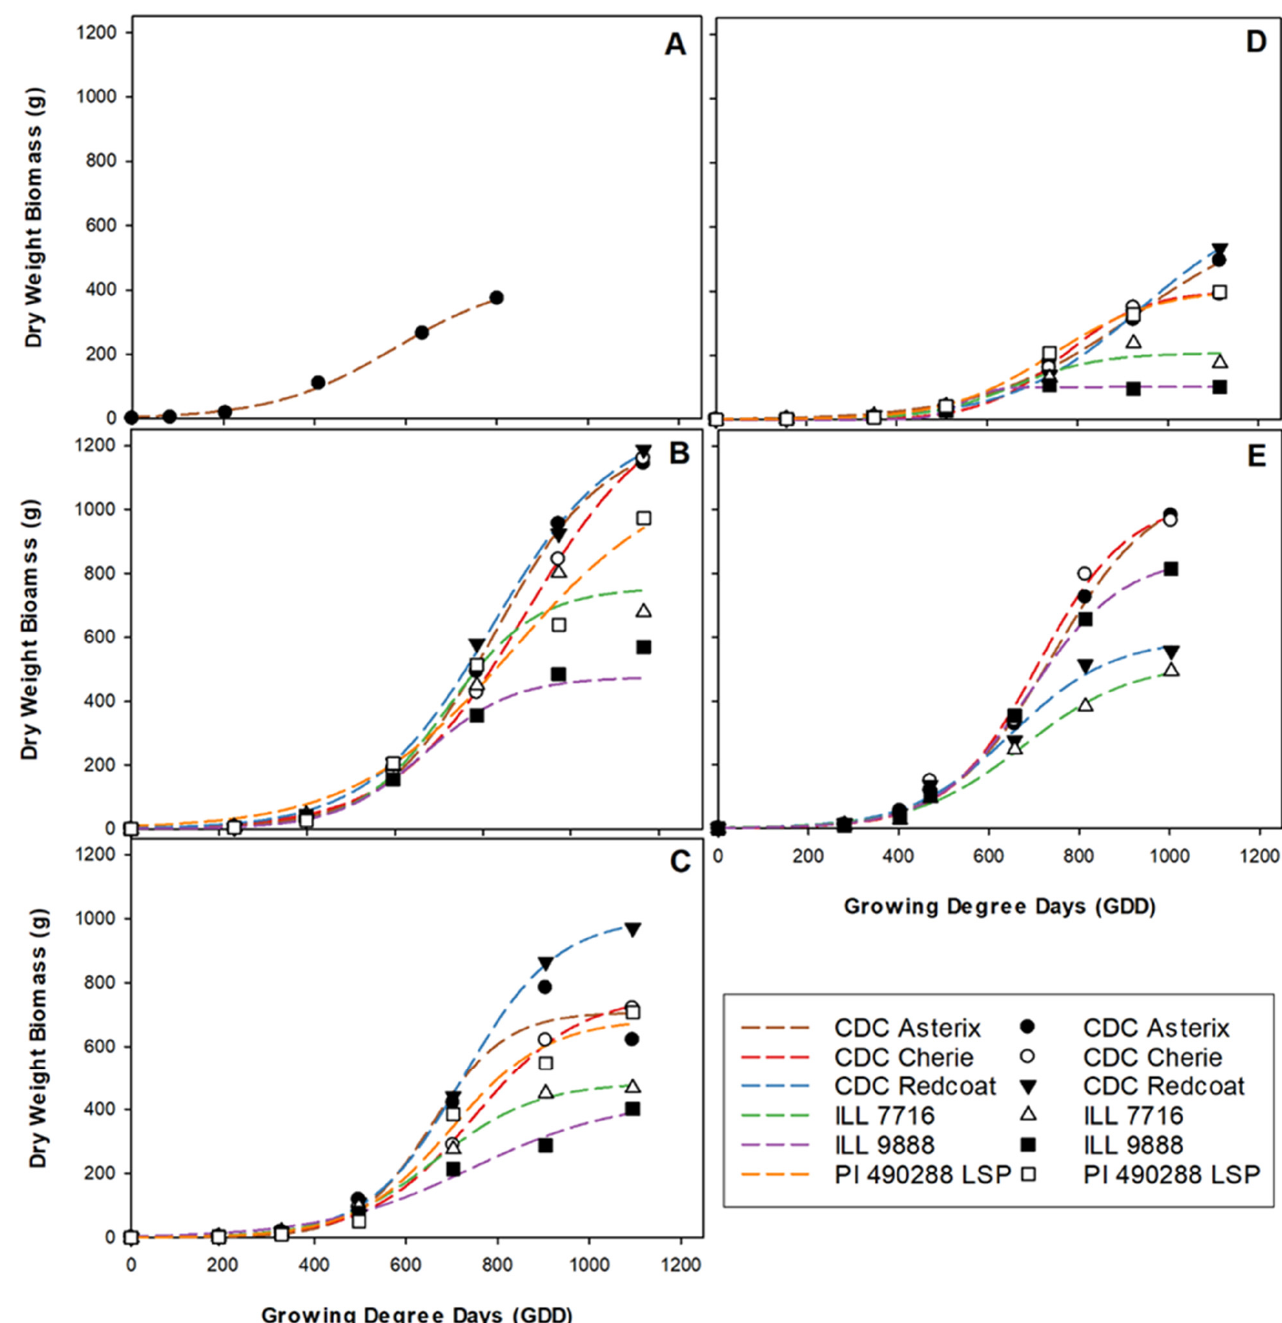
Figure 1. Three-parameter growth curves showing dry weight biomass accumulation for each genotype throughout the growing season at each site-year; Nasser 2017 ( A ), Rosthern 2017 ( B ), Sutherland 2017 ( C ), Nasser 2018 ( D ), and Rosthern 2018 ( E ). Data at Nasser 2017 was best described by combining all genotypes within the model.